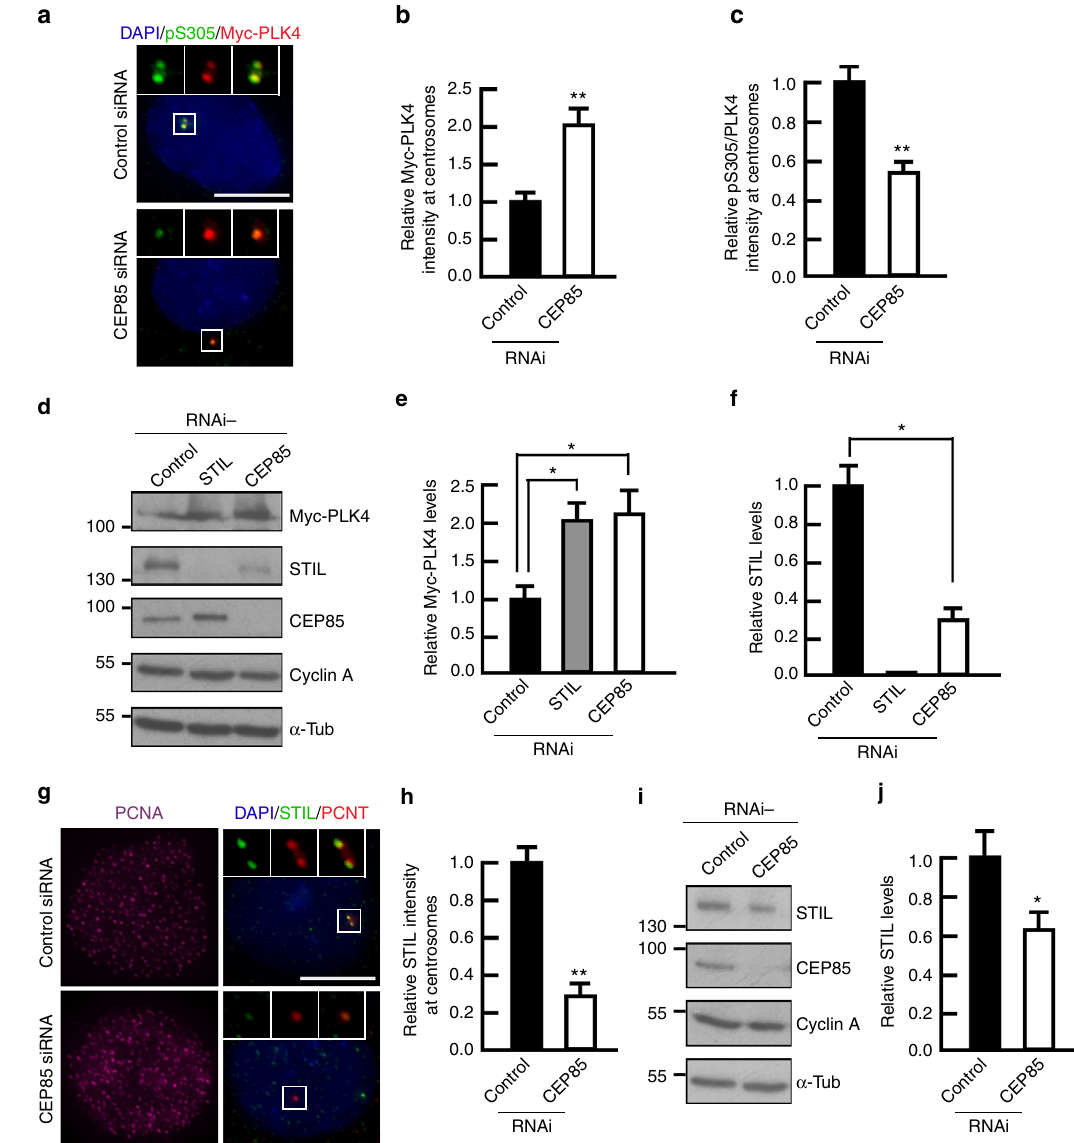
Fig. 2 CEP85 is required for PLK4 activation and STIL localization to centrosomes. a – c Examining the impact of CEP85 depletion on PLK4 activation using the PLK4-induced centriole overduplication assays (see Methods). Selected images showing Myc-PLK4 and PLK4 pS305 labelling. Scale bar 10 μ m, white boxes indicate the magni fi ed region. b , c The graph indicates the levels of Myc-PLK4 and the relative ratio of pS305/PLK4 at centrosomes after depletion of endogenous CEP85. ( n = 200/experiment, three independent experiments). d – f Western blot showing the levels of Myc-PLK4, CEP85 and STIL in control or CEP85 siRNA transfected cells. Cyclin A was used as a cell cycle marker and α -tubulin served as a loading control. e , f Quanti fi cation of protein levels shown in D ( α -tubulin normalized, n = 2/experiment, fi ve independent experiments,). g , h IF analysis of STIL localization in control or CEP85- depleted cells. The S-phase arrest assays were performed as described in Methods, followed by labelling with DAPI and the indicated antibodies. Scale bar 10 μ m, white boxes indicate the magni fi ed region. h Quanti fi cation showing the relative levels of STIL at centrosomes in PCNA-positive cells ( n = 200/ experiment, three independent experiments). i , j Western blot indicates the levels of STIL and CEP85 in control or CEP85 siRNA treated cells. Cyclin A and α -tubulin served as a cell cycle marker and loading control, respectively. j Quanti fi cation of the indicated protein levels shown in I ( α -tubulin normalized, n = 2/experiment, fi ve independent experiments). Two-tailed t -test was performed for all p -values, all error bars represent SD, and asterisks for p -values are ** p < 0.01 and * p <